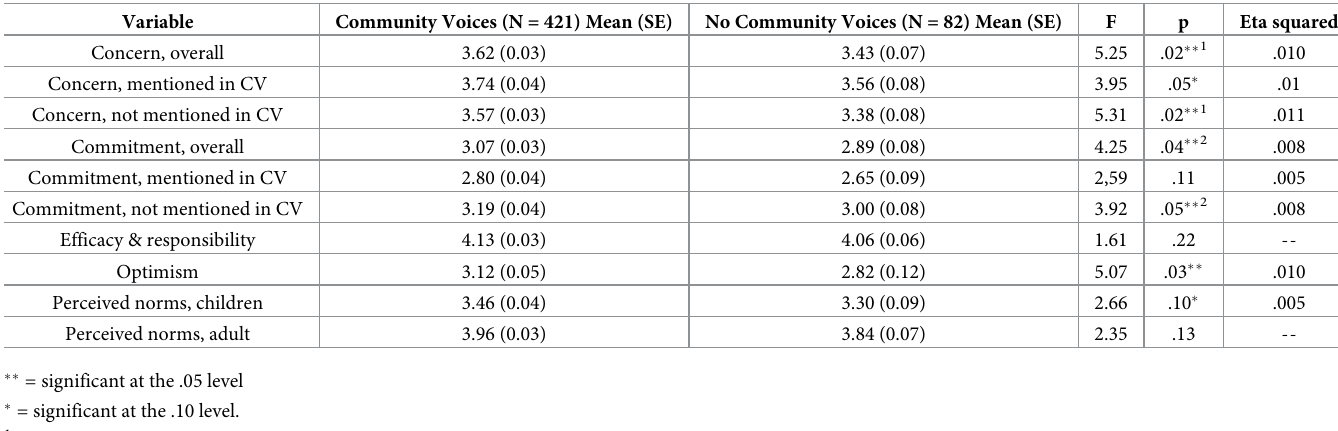
Table 3. Adjusted means (controlling for CNS and political orientation), SEs, and F statistics comparing exposure to community voices vs no